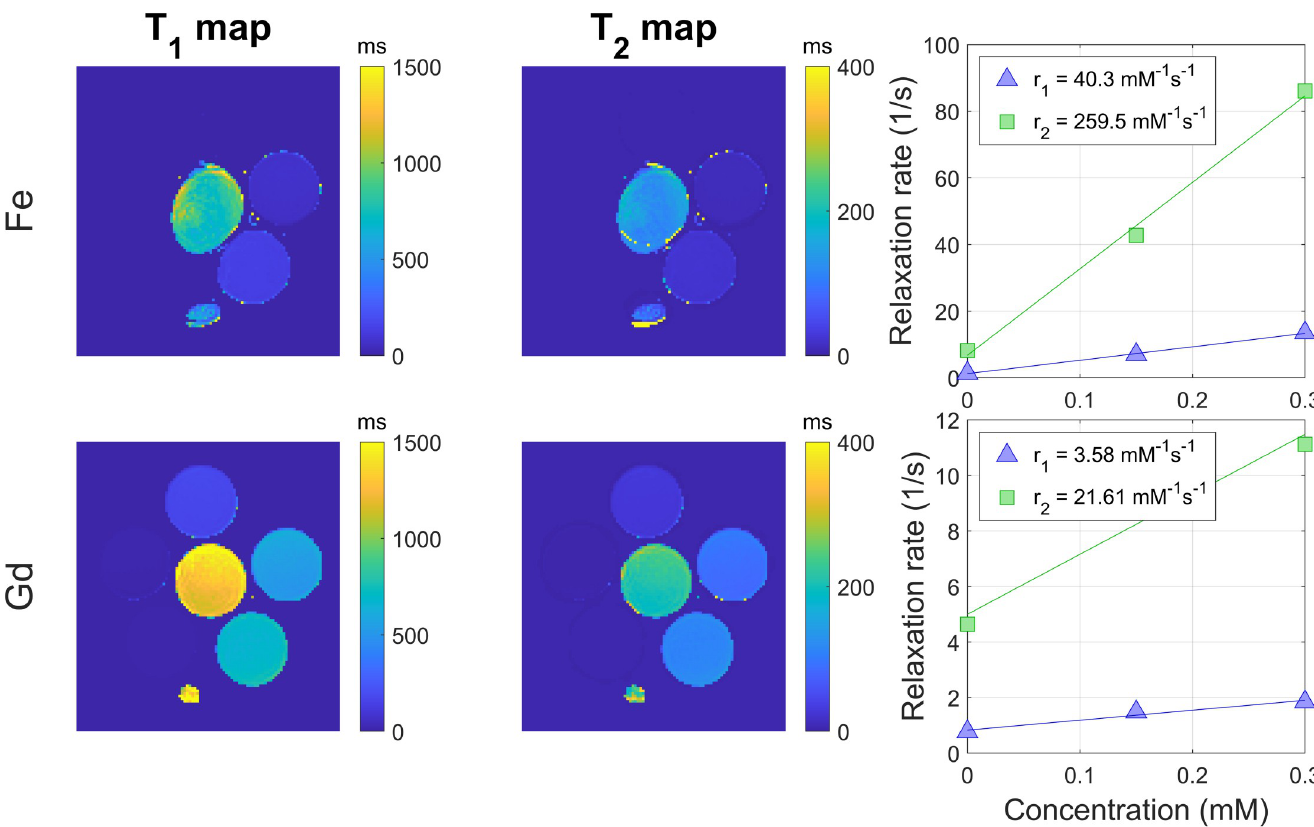
Fig 2. T 1 maps (left column) that were calculated with NOVIFAST and used as input for the DESPOT2 method to generate the T 2 maps (middle column). T 1 and T 2 values in the samples were used to calculate relaxation rates as function of the concentration (right column). For ferumoxytol (top row) and gadoterate (bottom row) relaxivity values were fit based on the relaxation